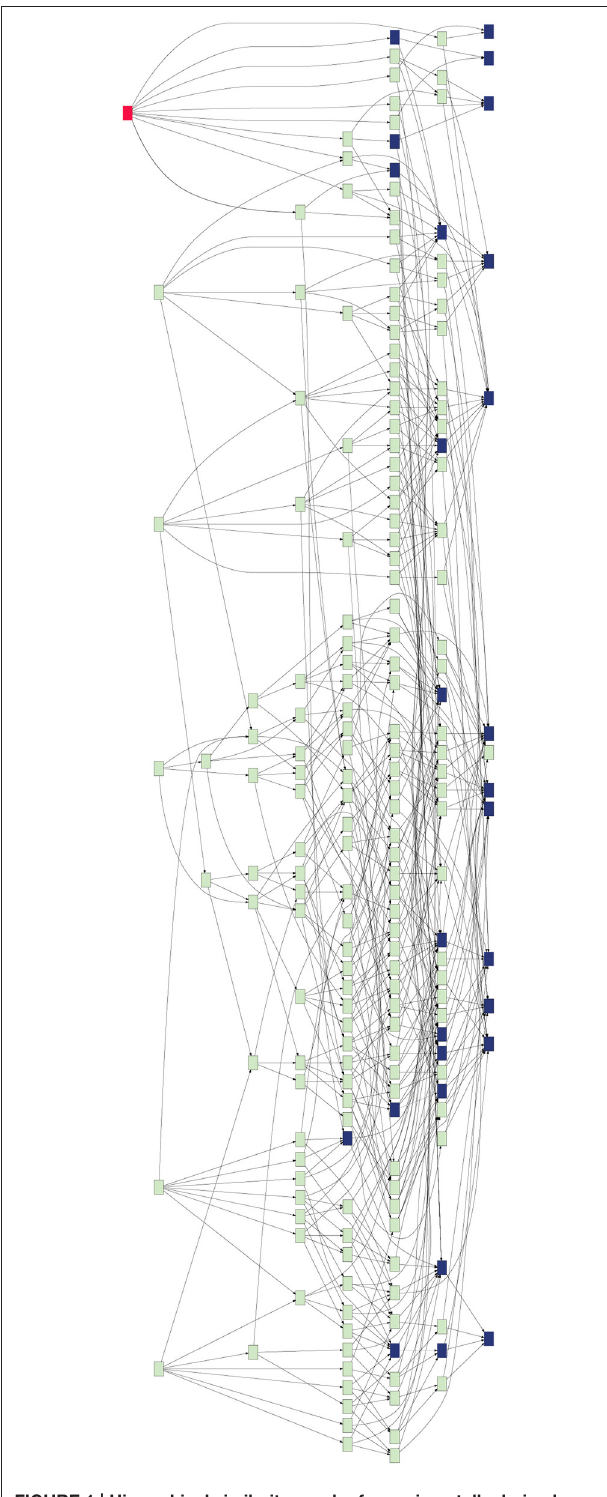
FIGURE 1 | Hierarchical similarity graph of experimentally derived alcohol-related genes sets. Terminal nodes, which are shown at the right-most level of the graph, represent the individual gene sets retrieved from the GeneWeaver database and each level above reflects higher order